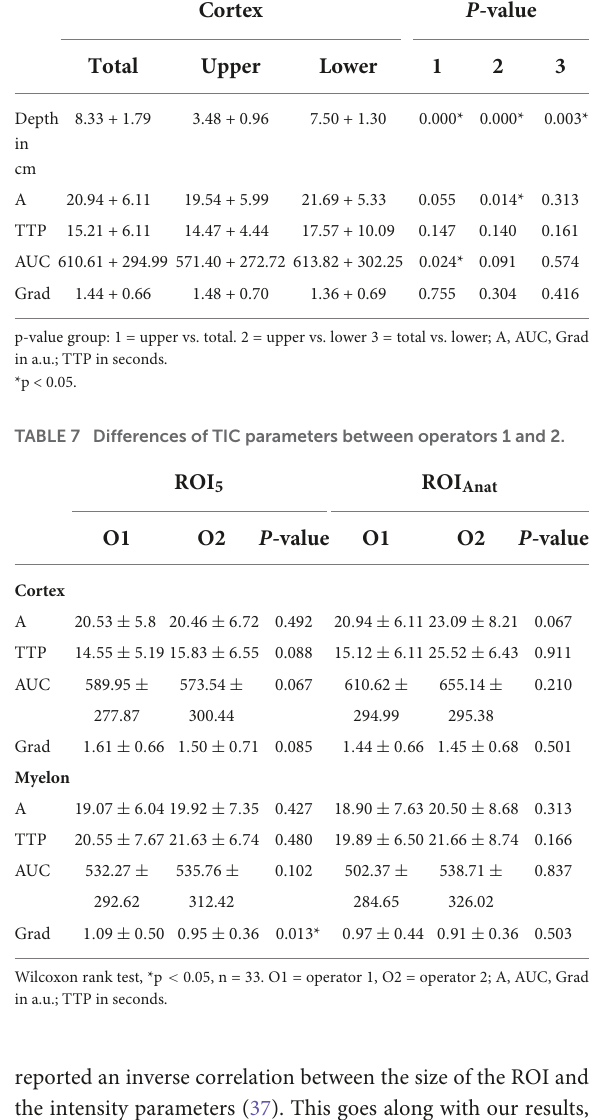
TABLE 8 Intraclass correlation between TIC parameters of operators 1 and 2.